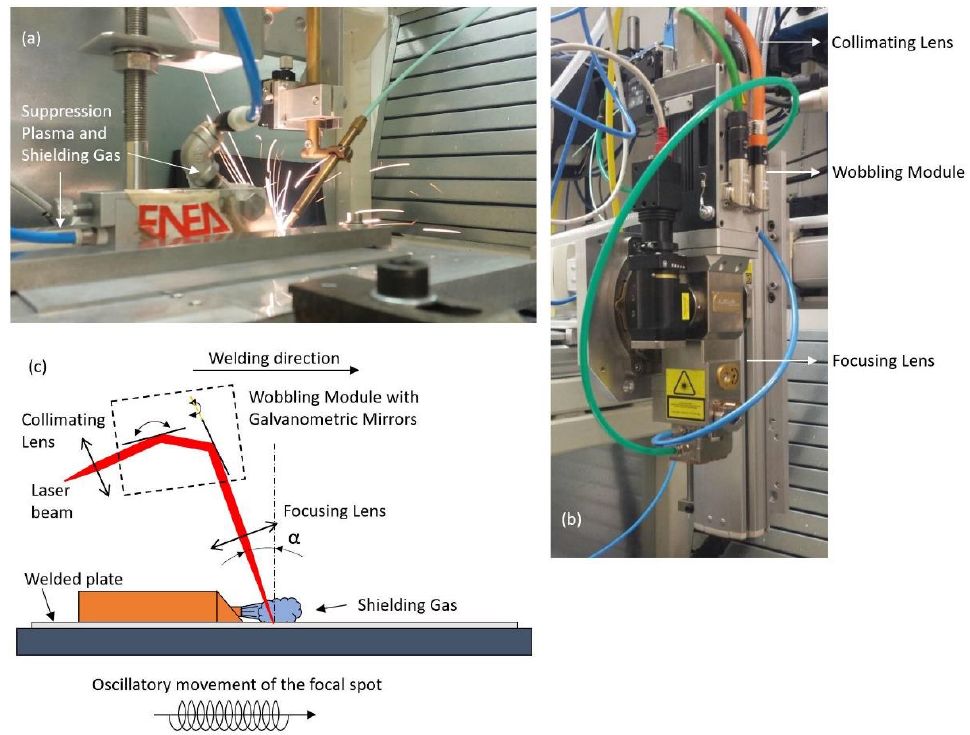
Figure 1. ( a ) Welding setup; ( b ) welding head; ( c ) working principle diagram.